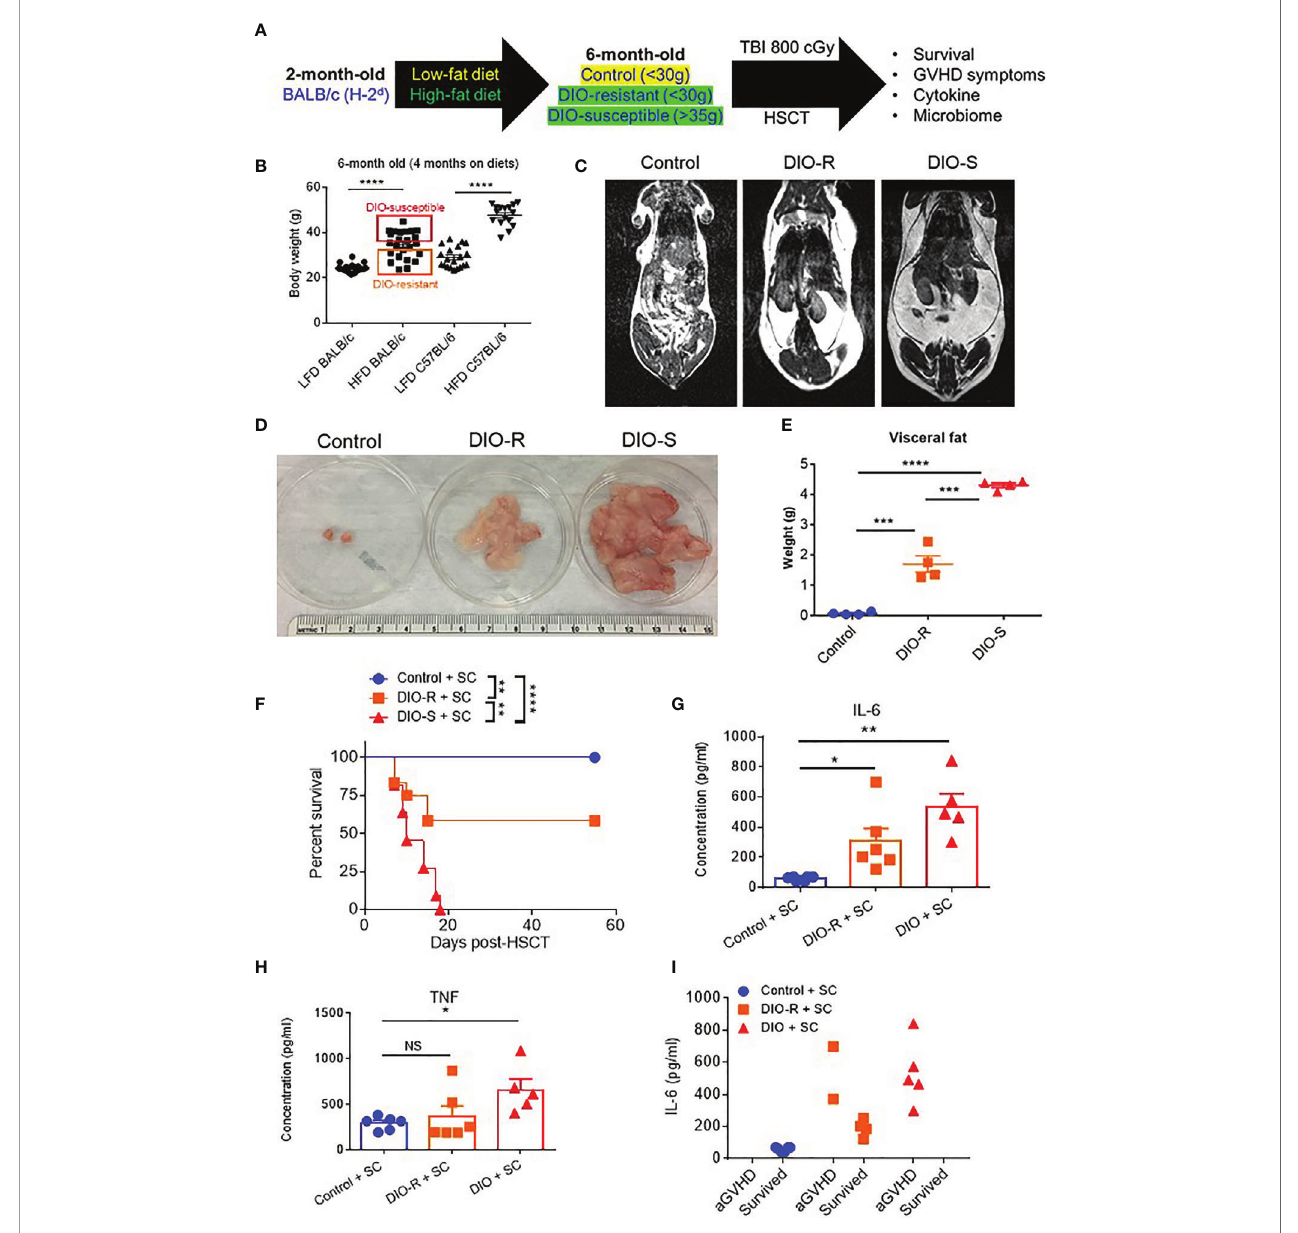
FIGURE 1 | (A) Lethally irradiated control, DIO-R, and DIO-S BALB/c mice received 8 million bone marrow cells and 25 million splenocytes from donor B10.D2 mice. (B) Body weights of BALB/c and C57BL/6 mice after 4 months on LF or HF diet (n=16-24/group). (C) Magnetic resonance imaging scans of control, DIO-R, and DIO-S mice. Fat tissue is white. (D) Representative images of visceral fat content of control, DIO-R, and DIO-S mice. (E) Quanti fi cation of visceral fat content of control, DIO-R, and DIO-S mice (n=4/group). (F) Survival rate post-HSCT (n=12/group). (G) Serum IL-6 and (H) TNF concentrations at day 7 post-HSCT (n=5-6/ group). (I) Correlation between acute GVHD outcomes and IL-6 levels (n=5-6/group). Graphs depict mean ±s.e.m. Survival curve (F) was plotted on a Kaplan-Meier curve and analyzed by a log-rank test. One-way ANOVA test was used in (B, F, G) . *p < 0.05, **p < 0.01, ***p < 0.001, ****p < 0.0001, NS, not signi fi